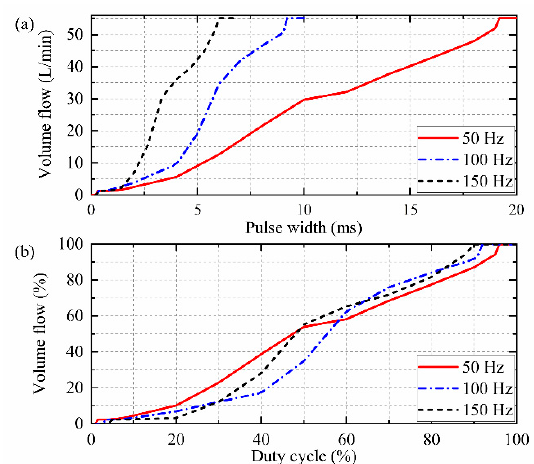
Figure 5. Standard and normalized results from 0.3 MPa pressure difference using three PWM frequencies: ( a ) Standard results; ( b ) Normalized results.